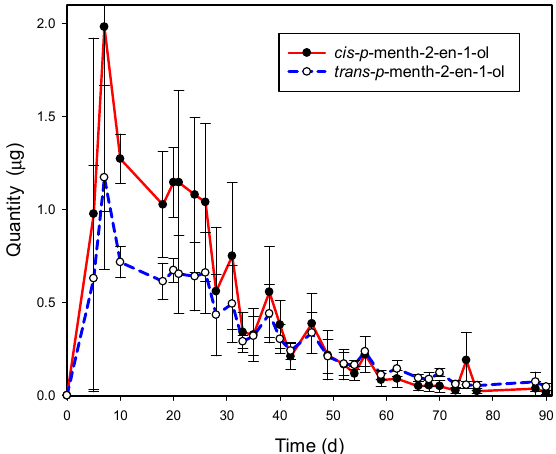
Figure 5. Emissions of cis - and trans - p -menth-2-en-1-ol quantified over time from cultures of Graphium sp. Volatiles were isolated by Super-Q collection (15 min adsorption), followed by GC-FID analysis (DB-5 column).